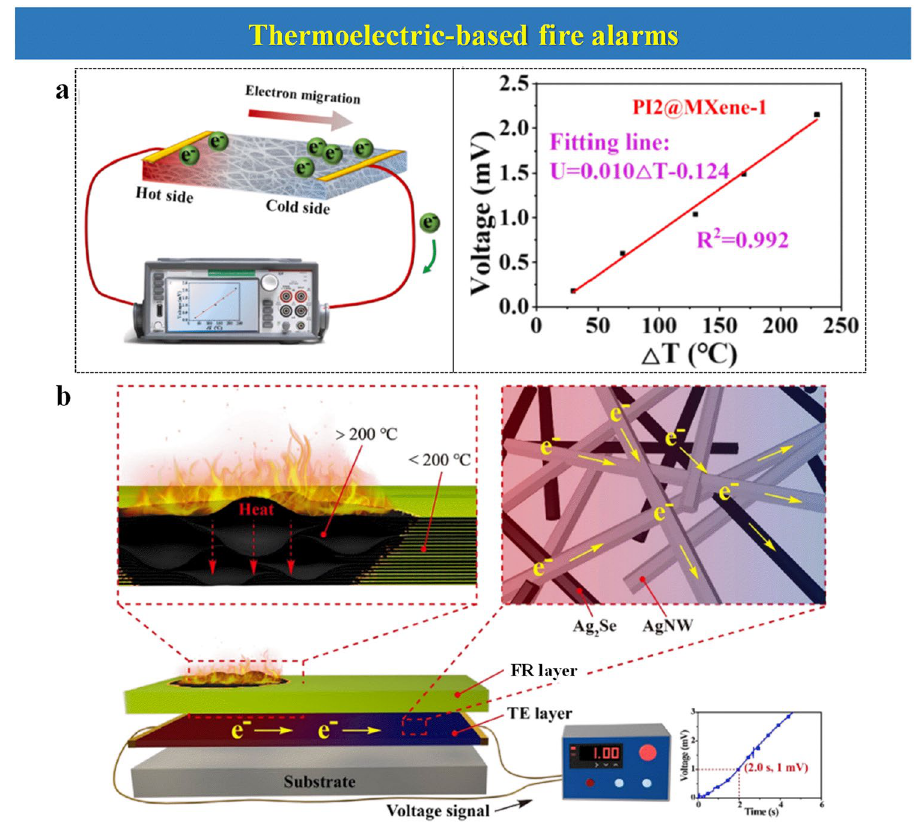
Fig. 11 Typical relevant TE‑based EFWSs: a The schematic diagram of a temperature sensing for PI@MXene and the liner fitting curve of cor‑ responding voltage vs temperature difference. Reproduced with permission from Ref. [35]. Copyright 2022 Elsevier. b Structural illustration of TE‑based EFWS. Reproduced with permission from Ref. [55]. Copyright 2021